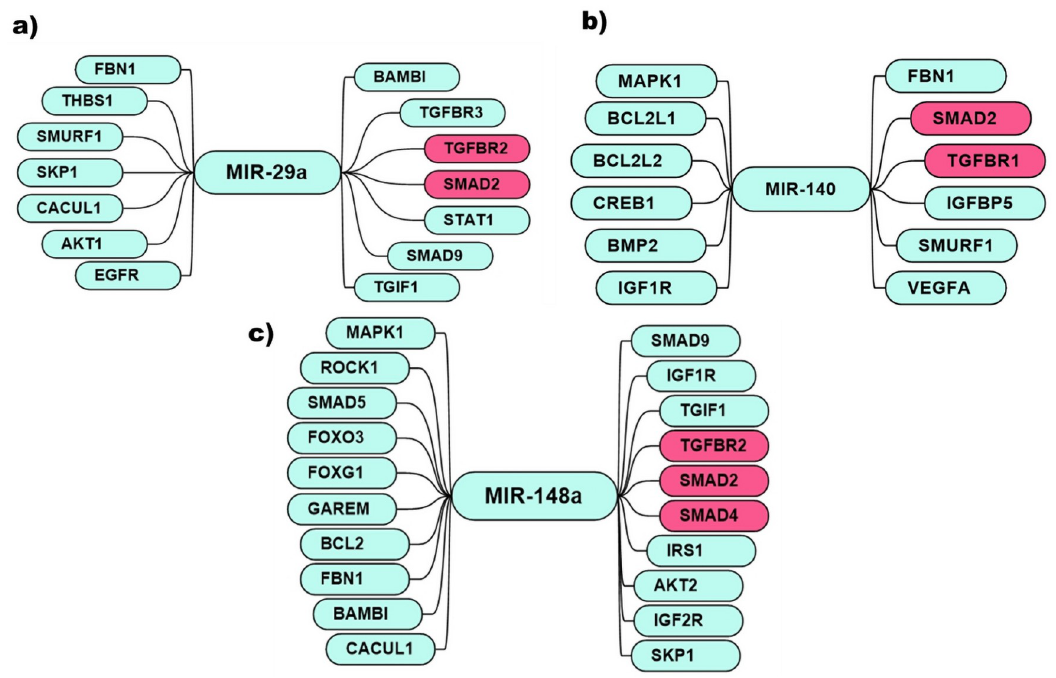
Fig 2. miRNA-target gene network analysis. Predicted targets of a) miR-29a, b) miR-140 c) miR-148a. Genes represented in the red box are studied in the current study in clinical samples.